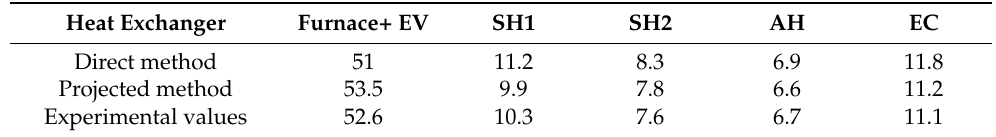
Table 9. Direct method and projected method heat transfer rate results for 100% MCR biomass boiler case